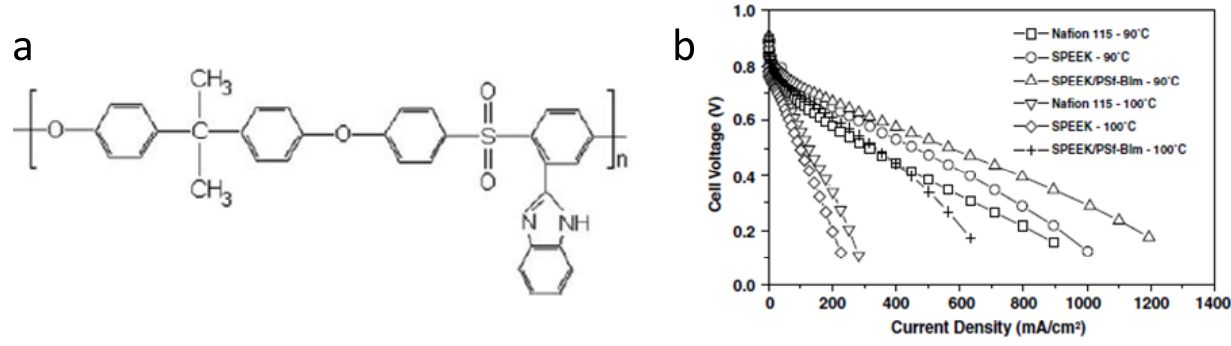
Figure 4. ( a ) Polysulfone bearing benzimidazole side group; ( b ) fuel cell performance of SPEEK/PSf-BIm blend membranes in comparison with plain SPEEK and Nafion. (Reprinted with permission from [42]. Copyright 2006